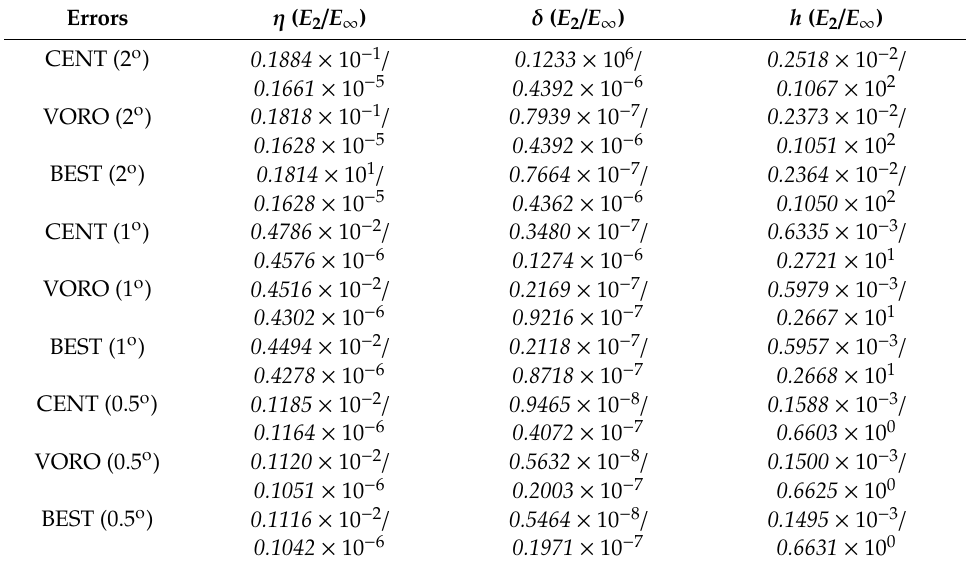
Table 2. Forecast errors on the 14th day of the two Z-grid models of CENT, VORO and BEST.